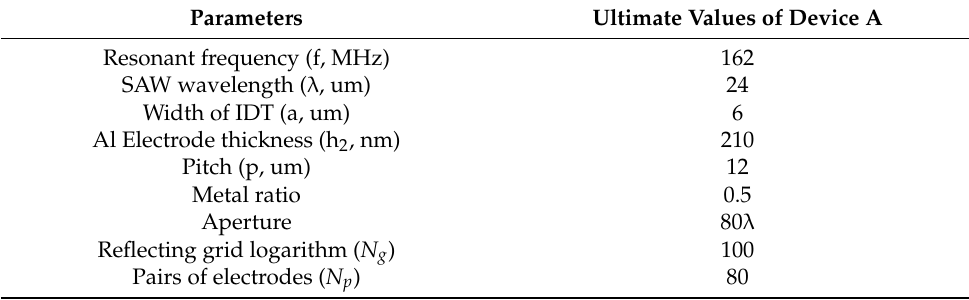
Table 2. The ultimate design of the SAW sensor with single electrode